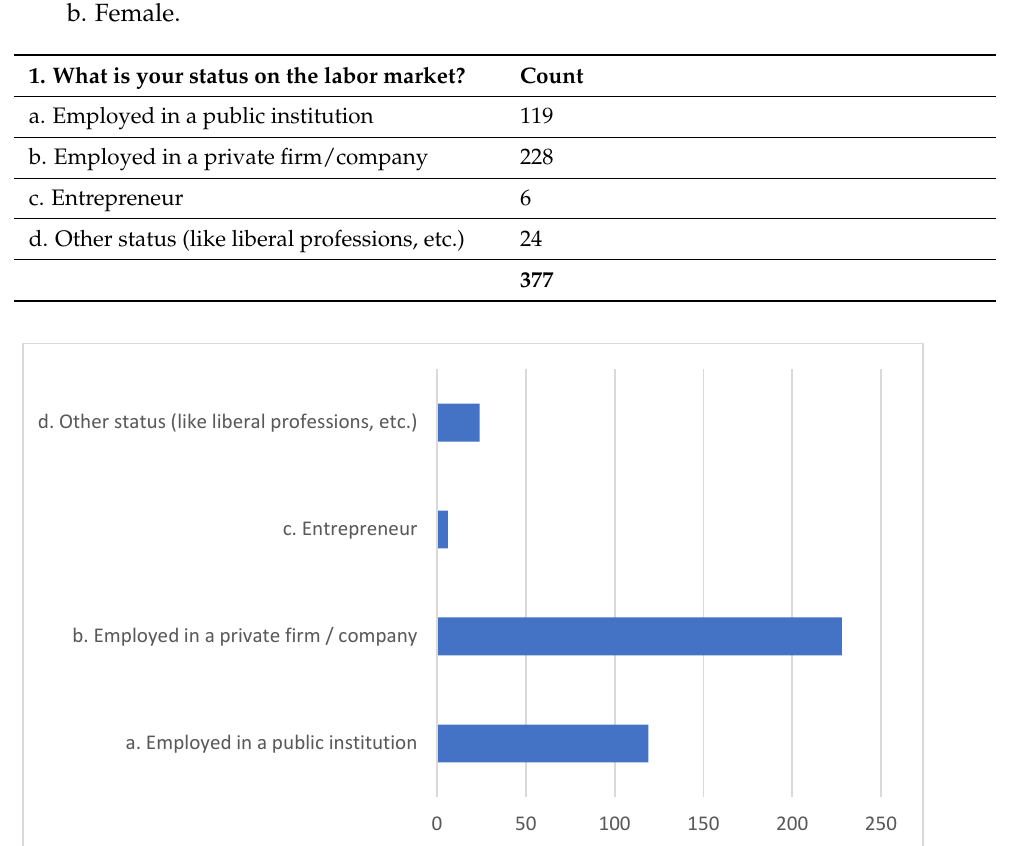
Figure A1. Status of respondents on the labor market.